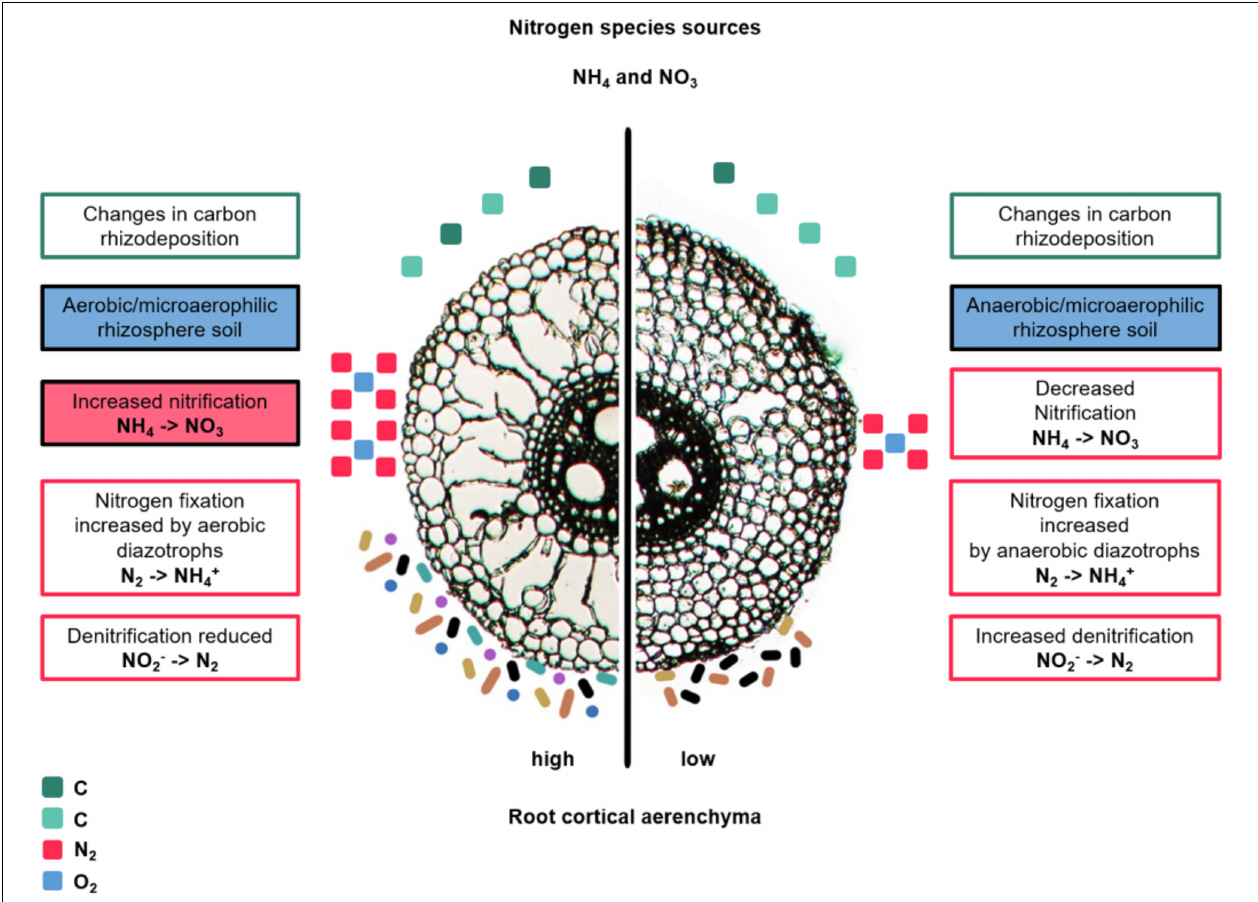
FIGURE 4 | Hypotheses about changes in diversity, abundance and N transformation capacity of the bacterial community in the rhizosphere of maize due to changes in RCA. The text boxes describe hypotheses about root-derived carbon, air, and nitrogen transformation. Carbon rhizodeposition is represented by green square icons; the number of icons is related to the hypothesized change in amount of C deposited at each RCA phenotype. The more icons, the more carbon. The differences in green tones indicate changes in biochemical composition. Air is represented by blue and pink square icons, corresponding to O 2 and N 2 , respectively. The number of icons represent the hypothesize change in amount of air. The colored bastons and circle icons represent bacterial communities and their different colors represent diversity (more colors, greater diversity); the number represent the expected microbial abundance (not to scale or proportional to the actual amounts). The hypothesis for which experimental support exists are in color-filled text boxes (Risgaard-Petersen and Jensen, 1997; Arth and Frenzel, 2000; Kennedy et al., 2004; Li et al., 2008; Galindo-Castañeda, 2018), while hypothetical statements are written in non-color-filled text